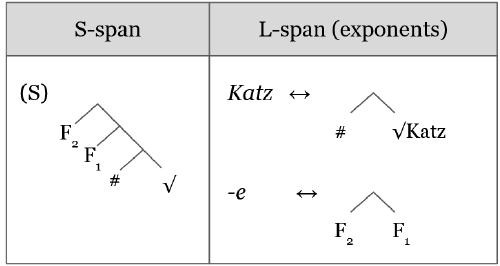
Figure 5. Spellout of PD {e}